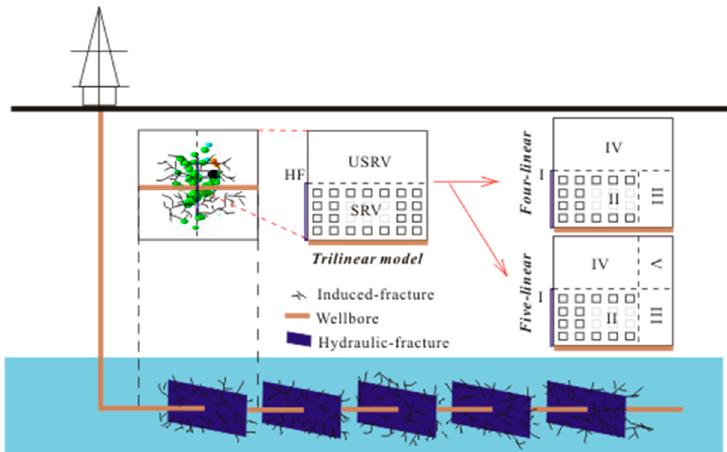
Figure 1. Simplified physical model and three typical presented linear-flow models for a multi-fractured horizontal wells (MFHW) in unconventional reservoirs.